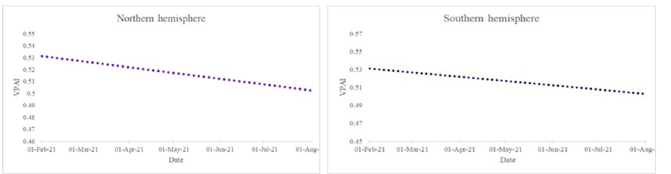
Fig 5. Trend in positive attitude across the Northern and Southern hemispheres from February 2021 to the end of July 2021. Source: Authors’ calculations.